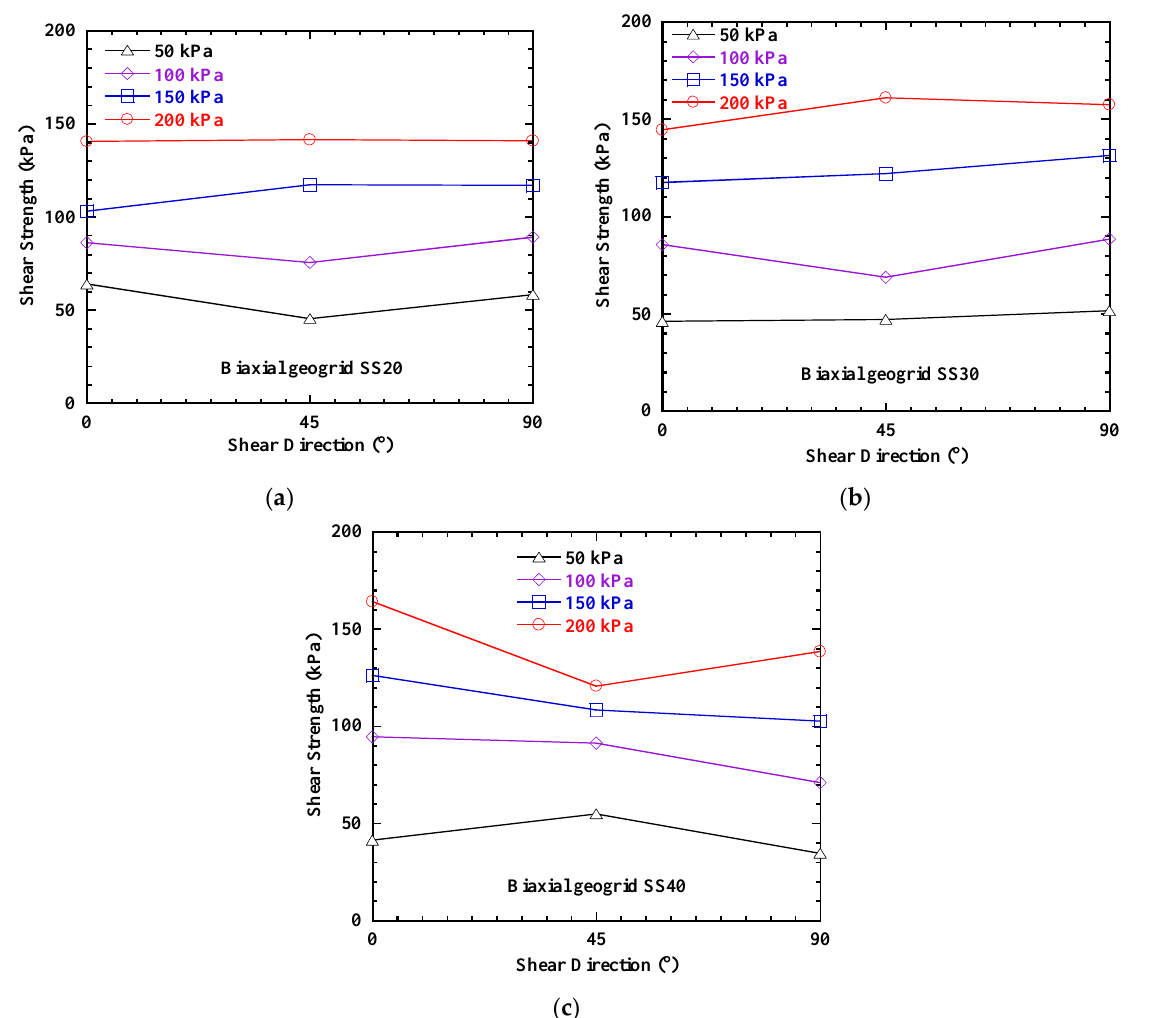
Figure 7. The influence of shear direction on the shear strength of fine sand–biaxial geogrid interfaces. ( a ) SS20, ( b ) SS30, ( c ) SS40.